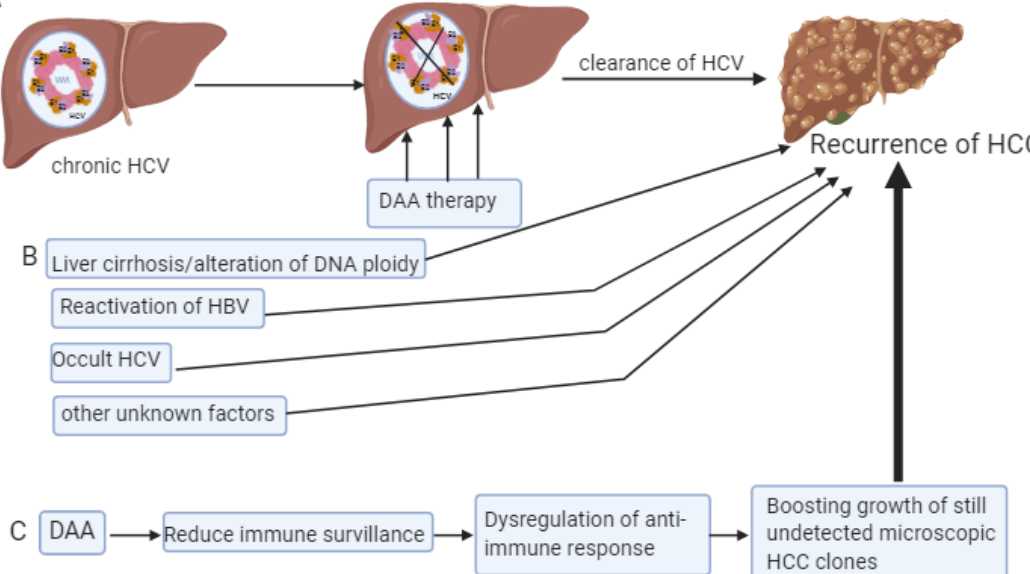
Figure 2. Schematic diagram representing the possibilities of HCC development in patients treated with direct acting antivirus agents (DAA). Panel ( A ) shows the development of HCC in patients treated by DAA. Panel ( B ) represents factors which may be associated with the development of HCC in general. Panel ( C ) represents a schematic hypothesis of HCC development in patients treated with DAA.